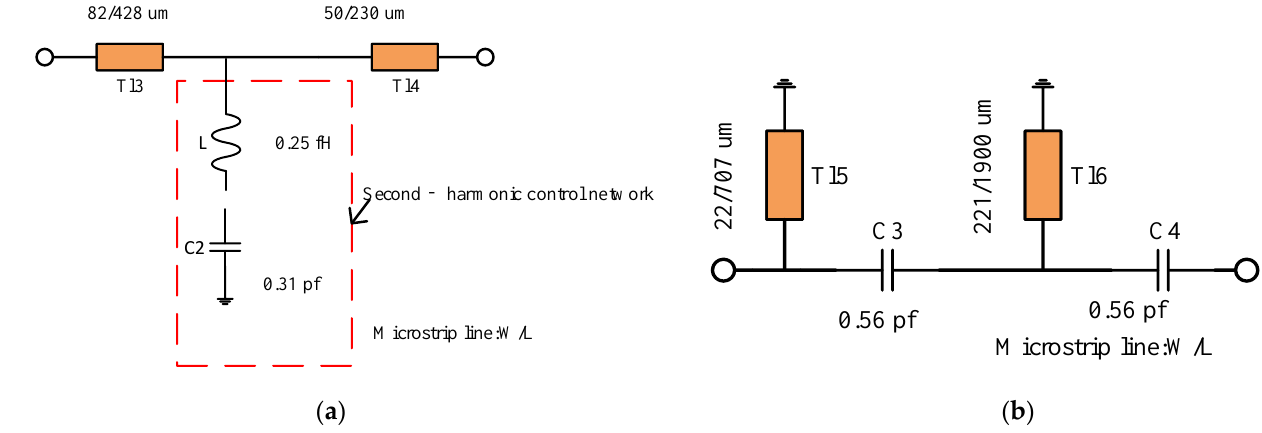
Figure 10. The block diagram of the circuit structure: ( a ) ISMN; ( b ) IMN. The insertion loss and return loss simulation results of the ISMN are shown in Figure 11a. With a return loss better than 12 dB, the insertion loss is 1.4 – 0.7 dB across the frequency range of 7-13 GHz; the simulation result of the IMN is shown in Figure 11b. With a return loss better than 10 dB, the insertion loss is 2.8 – 1.2 dB across the frequency range of 7-13 GHz.